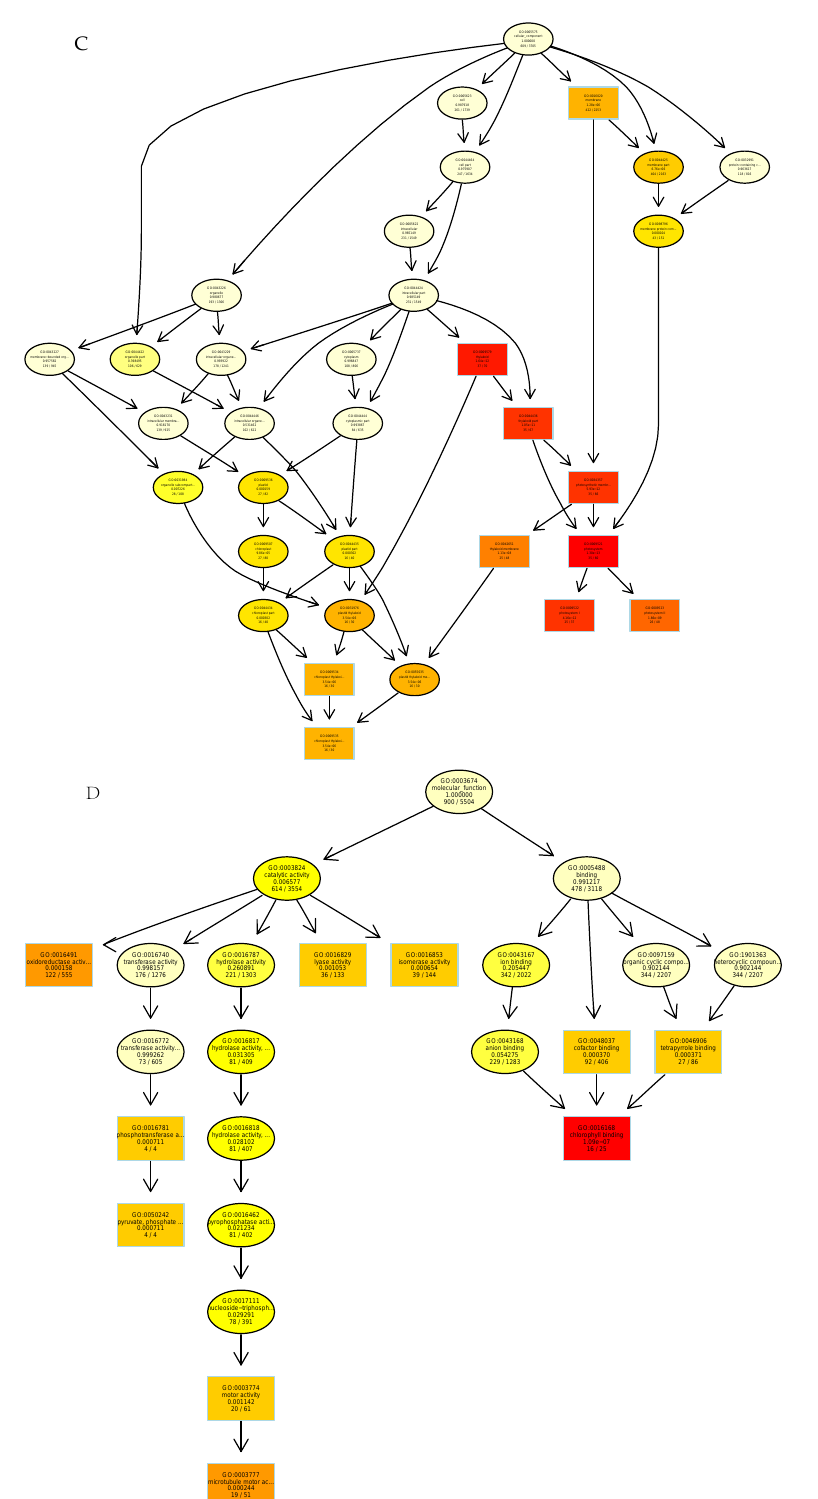
Figure 3. GO enrichment analyses of DEGs identified in H 2 O 2 -stimulated IEC-6 cells. ( A ) GO enrichment analyses of DEGs. The x -axis represents the number of DEGs and the y -axis represents the enriched GO terms. The size of the point indicates the number of DEGs enriched in the pathway, and the redder the color, the more significant the enrichment result is. ( B – D ) Thumbnails view of directed acyclic graphs (DEGs) on BP, CC, and